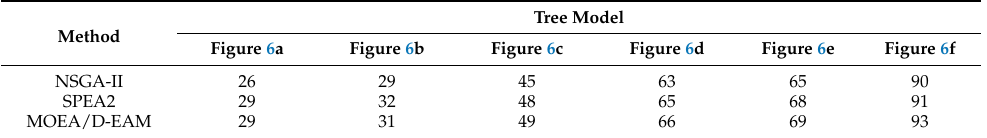
Table 5. Average running time (in seconds) of NSGA-II, SPEA2, and MOEA/D-EAM in pruning optimization